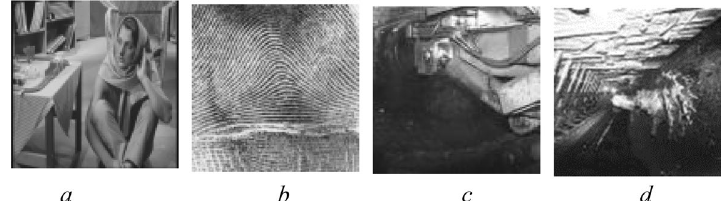
Fig. 7 The test images: a Barbara; b fingerprint; c coal cutter; d tunnel boring